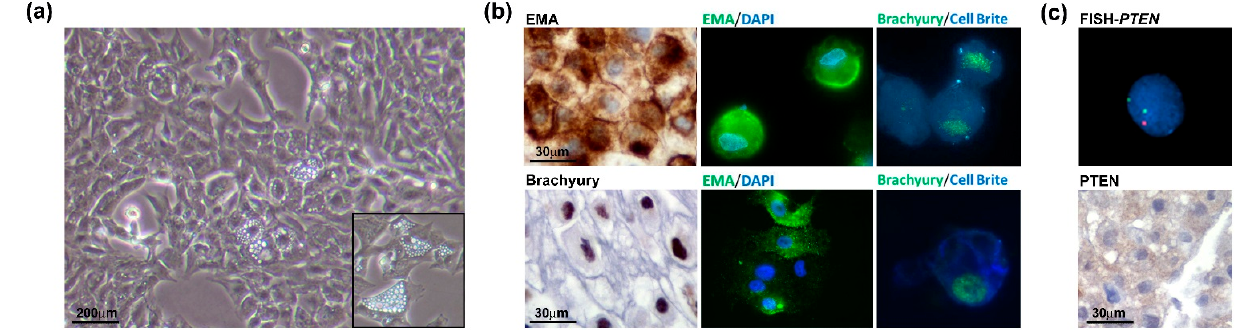
Figure 4. Chordoma cell line characterization. ( a ) Physaliphorous morphology of the chordoma cell line. The representative images of the CH3 cell line were taken at a magnification of 10× by a bright- field microscope. ( b ) CH3 cells express chordoma markers EMA and Brachyury during passages (P20, IHC, left panels; P10 IF, upper panels; P33, IF lower panels). For IF images, immunostaining of cells was performed for EMA and Brachyury, nuclei were stained using DAPI dye and cytoplasmic membranes using Cell Brite Blue. IHC images were taken at 60 × and IF images at 63 × original magnification (with immersion). ( c ) PTEN heterozygosity was confirmed in the CH3 cell line. The analysis was performed by FISH using PTEN/CEP10 probe, and nuclei were stained using DAPI ( top panel). Immunohistochemistry on the cell block showed a barely detected expression of PTEN protein ( lower panel).